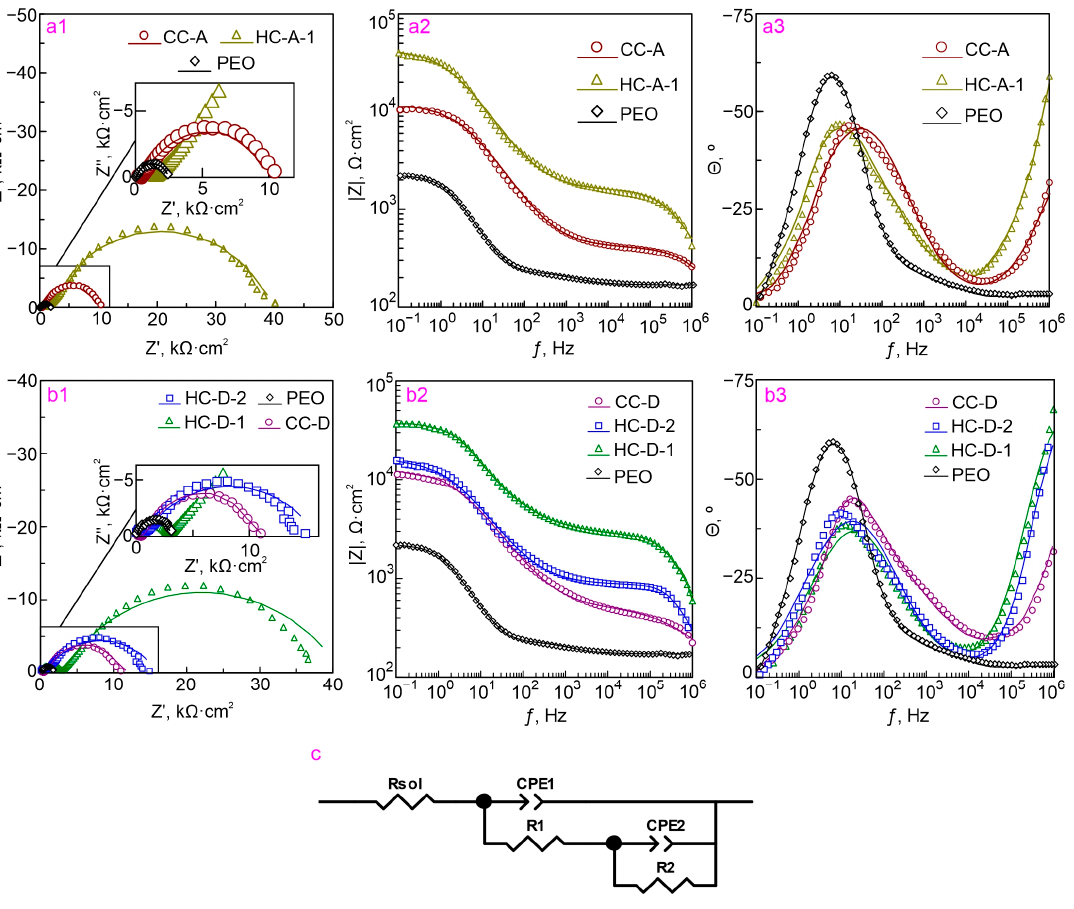
Figure 9. Impedance spectra Nyquist ( a1 , b1 ) and Bode plots ( a2 , a3 , b2 , b3 ) for the studied samples acquired after 10 min of exposure to 3.5 wt.% NaCl solution ( a , b ) and equivalent electrical circuit ( c ) used to fit the experimental data.